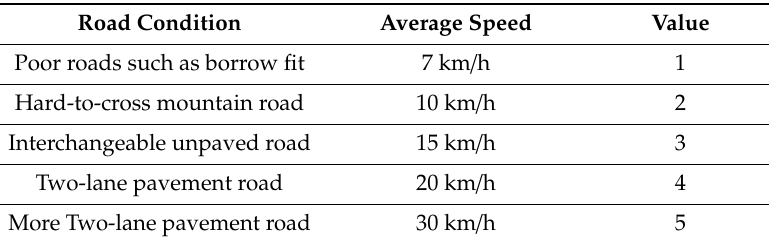
Table 4. Value for road condition.